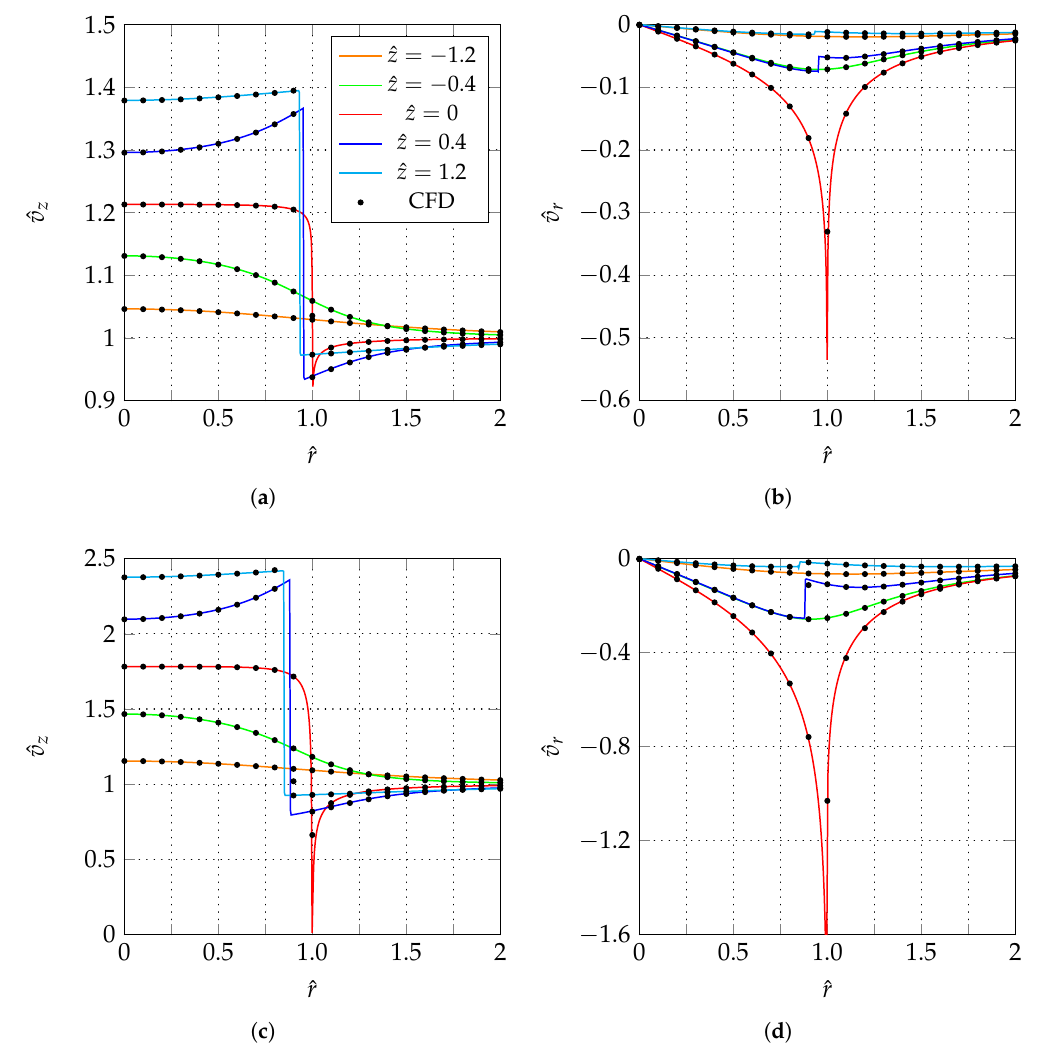
Figure 8. Comparison between radial profiles of the axial and radial velocity as obtained through the FWRV-AD (lines) and the CFD actuator disk (symbols) for ˆ z =